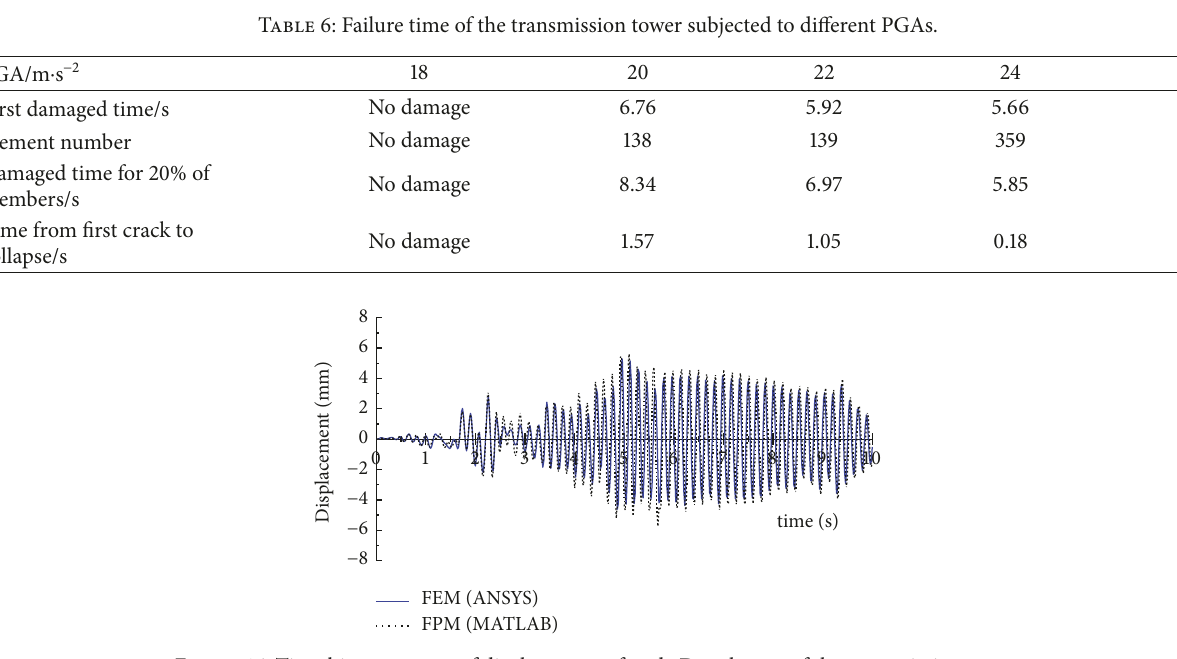
Figure 16: Time history curves of displacement of node D at the top of the transmission